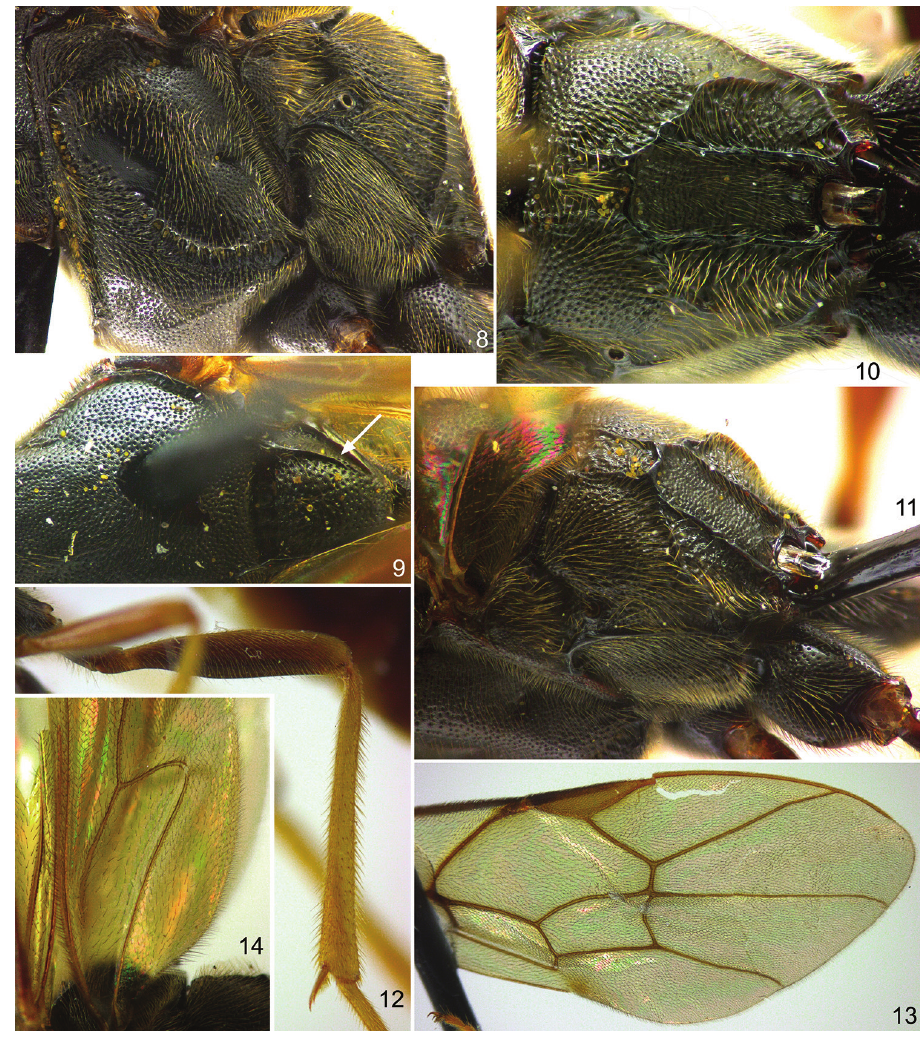
Figures 8–14. Stethantyx durrelli sp. n., female, holotype: 8 mesosoma, lateral view 9 mesoscutum and scutellum, lateral view 10 propodeum, dorsal view 11 propodeum, dorso-postero-lateral view 12 hind femur and tibia, lateral view 13 apex of fore wing 14 basal part of hind